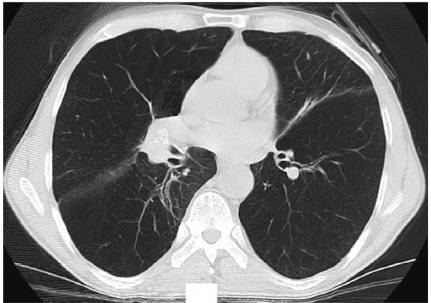
Figure 1: Pretreatment chest X-ray.